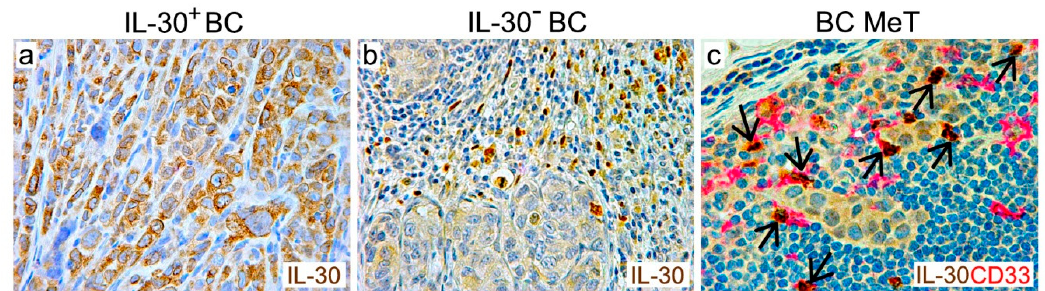
Figure 1. Expression of IL-30 in breast cancer and lymph node metastasis (MeT). Immunohistochemistry reveals the expression of IL-30 (in brown; ab118910, Abcam) in cancer cells of a Triple Negative breast cancer (BC) ( a ), in leukocytes infiltrating an HER2 + BC ( b ), and in both metastatic and myeloid cells (red), indicated by arrows (anti-CD33 antibody, clone PWS44; Leica Biosystems), in the lymph node draining this tumor ( c ). (Magnification: ×630).